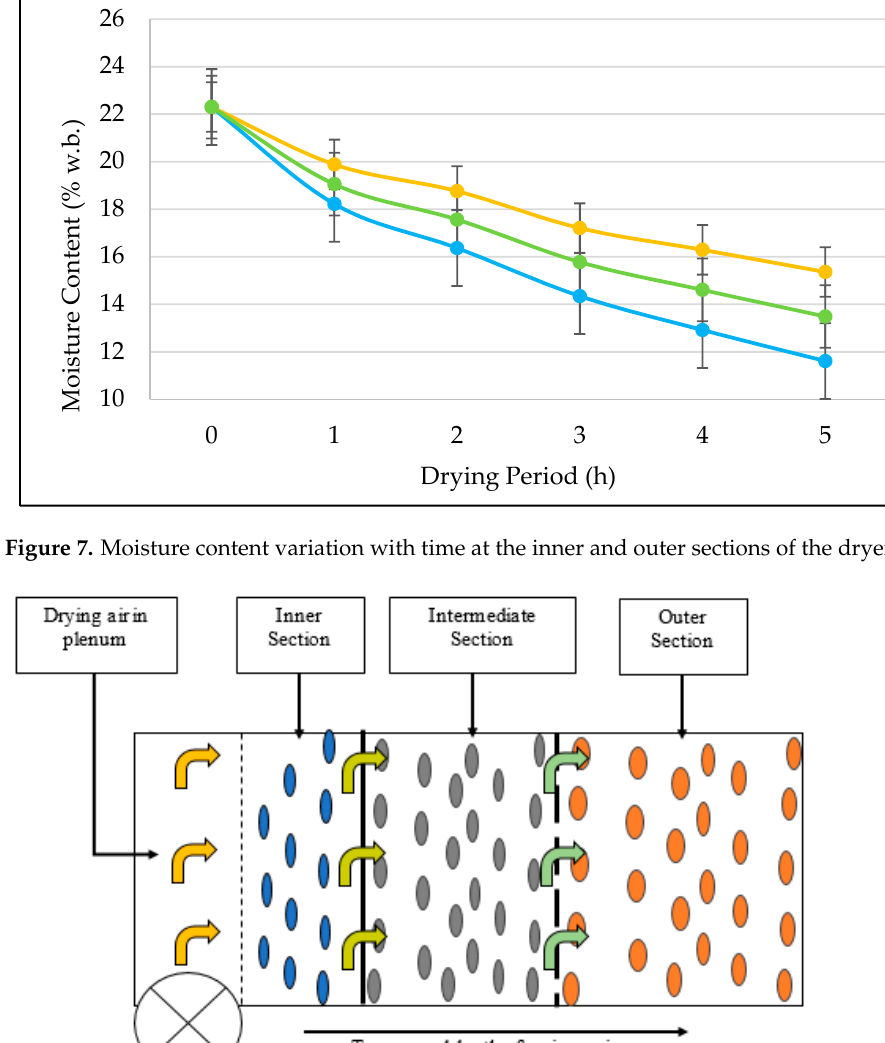
Figure 8. Schematics of the deep bed drying principle.